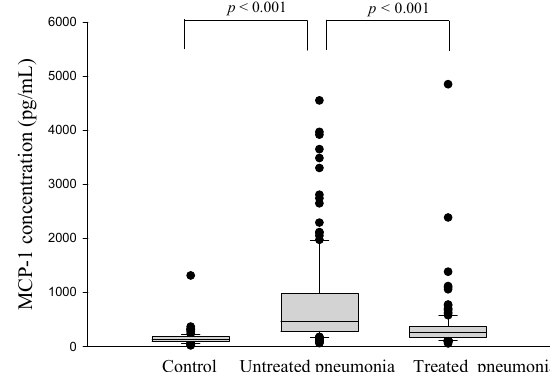
Figure 1. Levels of plasma monocyte chemoattractant protein (MCP)-1 in healthy controls and in patients with community-acquired pneumonia (CAP) before and after antibiotic treatment. The plasma MCP-1 level was significantly elevated in patients with CAP before they received treatment compared with the controls ( p < 0.001) and significantly decreased in patients with CAP after treatment ( p < 0.001).